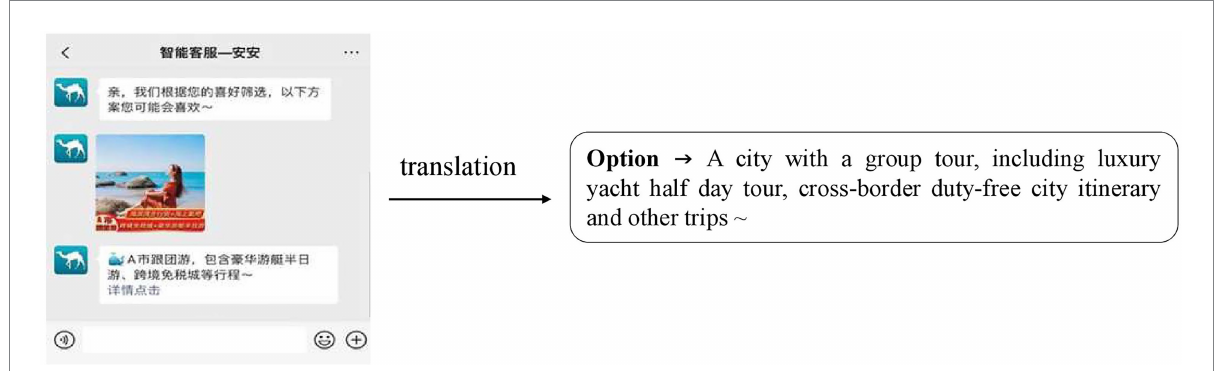
FIGURE 3 Experimental scenario of the number of recommended options 1. Images sourced from: m.qunar.com. Reproduced with